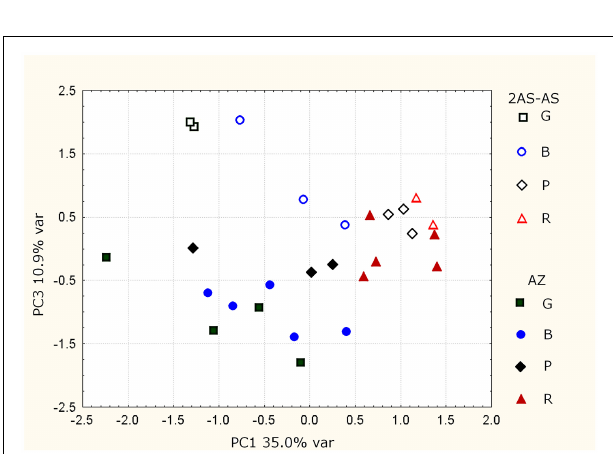
FIGURE 2 | Molecular abundance of 30 metabolites analyzed in fruit of 556AZ (AZ: gray boxes), 2AS-AS (black boxes), and 579X2AS-HO (white boxes) tomato lines at four ripening stages. (A) Amino acids. (B) GABA, organic acid, and sugars. (C) Miscellaneous including heteroaromatic compounds including nucleotides and ATP + ADP. Mean values and SEs are